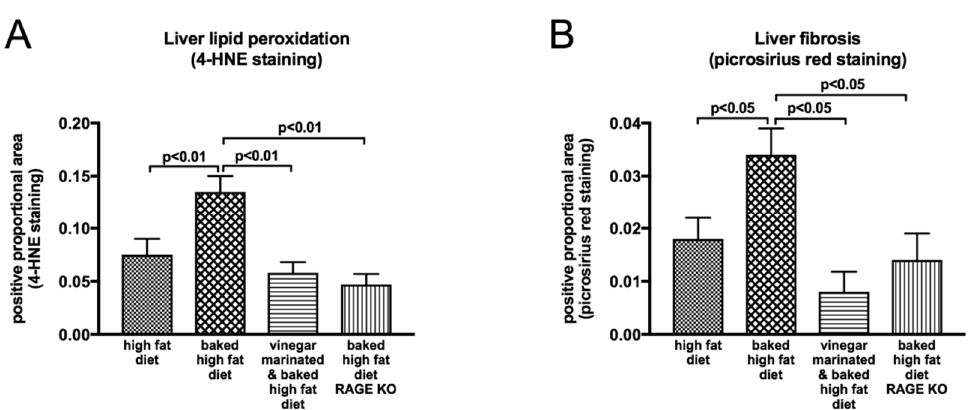
Figure 7. AGE-induced oxidative stress and liver fibrosis. Baking high fat diet at 160 ◦ C for 1 h significantly increases oxidative stress as reflected by increased lipid peroxidation in the liver ( A ) which in turn exacerbates NAFLD progression to NASH and liver fibrosis ( B ). Marination of high fat diet with vinegar prior to baking or RAGE deletion has beneficial effects as reflected by reduced liver oxidative stress ( A ) and liver fibrosis ( B ) [60]. 4-HNE: 4-hydroxynonenal.